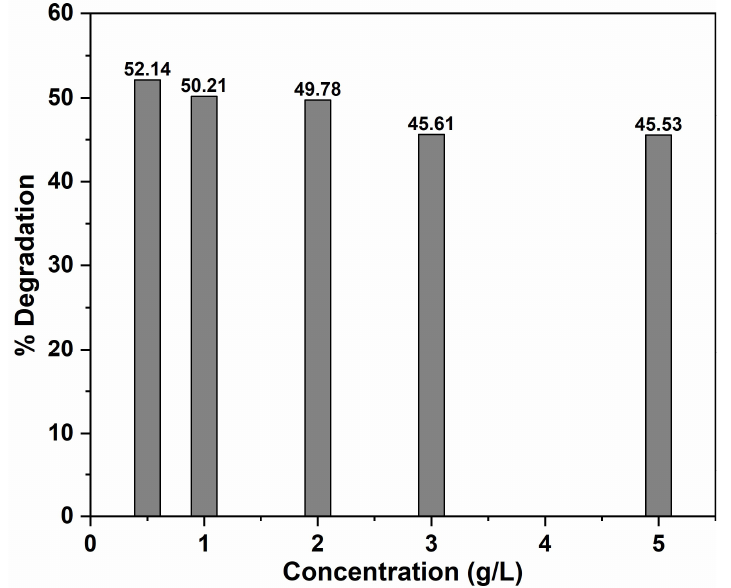
Figure 4. Degradation of ANB at different NaIO 4 concentrations (pH = 3.0 ± 0.2, FFGN = 0.5 g/L, ANB = 50 ppm, Amplitude = 40%, Probe = 25 mm, T = 25 ± 1 °C) .